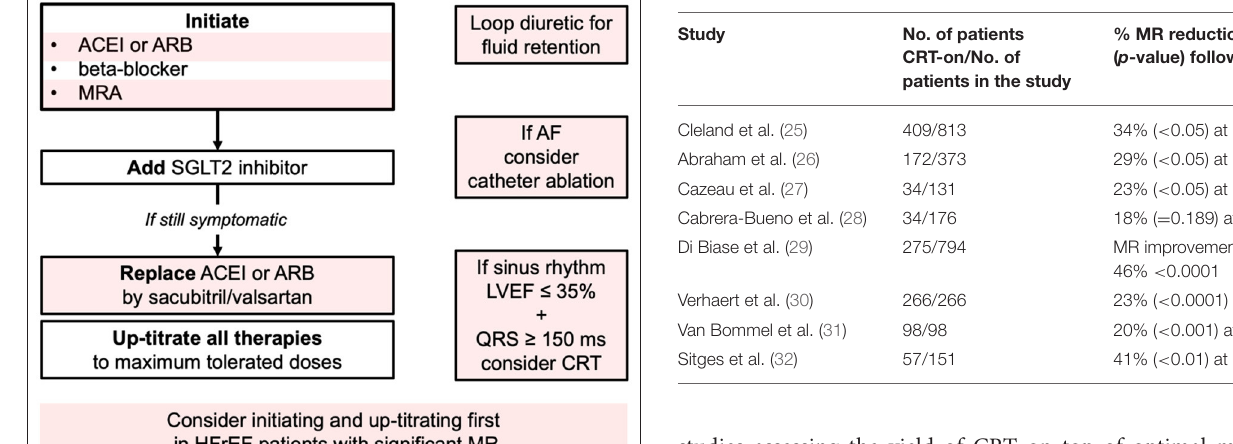
TABLE 1 | Studies evaluating MR reduction after CRT